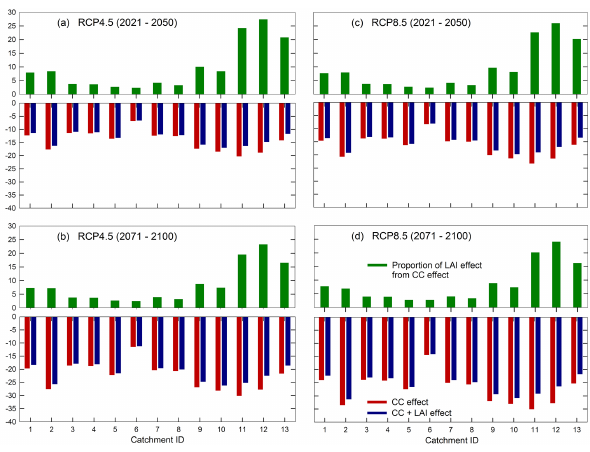
Figure 7. Impact on catchment mean annual streamflow average over the 38 CMIP5 runs of projected climate change for the fu- ture periods 2021–2050 and 2071–2100 under RCP4.5 (a, b) and RCP8.5 (c, d) , relative to the 1981–2010 base period. CC effect in- dicates precipitation and temperature effect with unchanged LAI; CC + LAI effect indicates precipitation, temperature and LAI ef- fect. The proportional LAI effect indicates the LAI effect as a per- centage of the CC